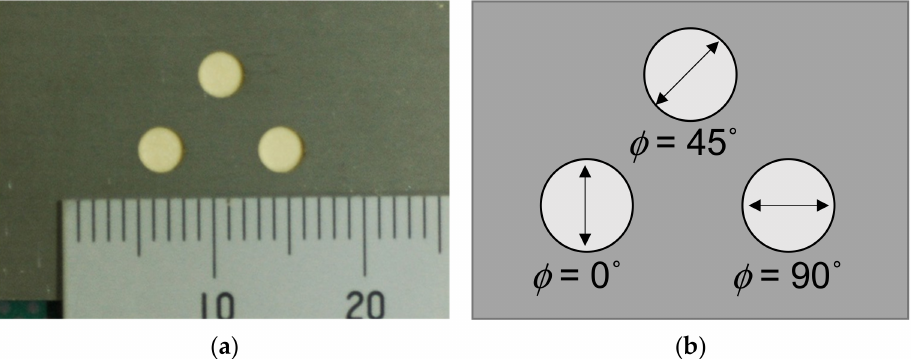
Figure 4. ( a ) Photograph of test object. ( b ) Schematic illustration of test object showing direction of liquid crystal orientation.